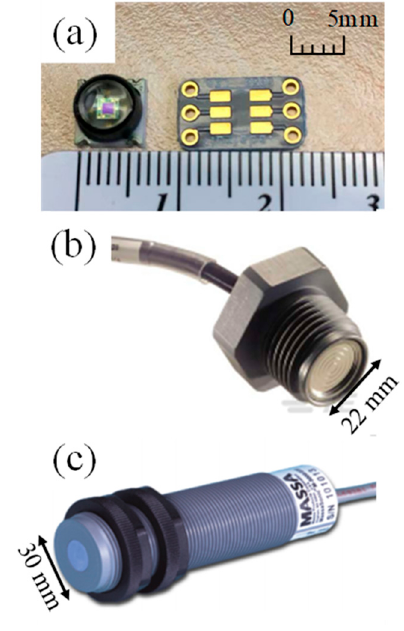
Figure 2. Instrumentation used for pressure and surge height measurements: ( a ) Honeywell Pres- sure Transducer (HPT); ( b ) TH connectivity LM-series Pressure Transducer (LMPT); ( c ) MASSA M-5000/220 Ultra-sonic sensor (MUSS).